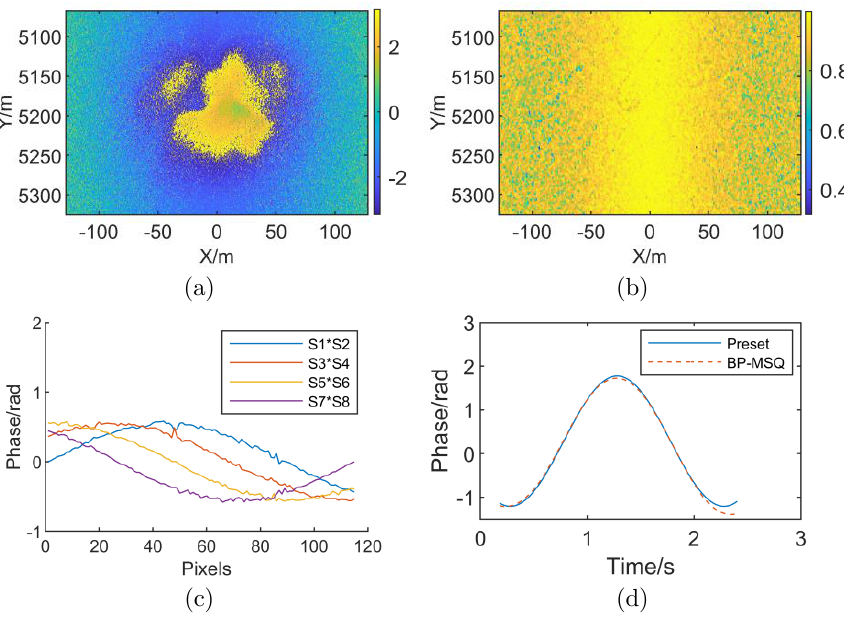
Figure 7. Stripmap SAR simulation results with high-order RME. ( a ) Interferometric phase with high-order RME ( b ) Coherence map with high-order RME ( c ) Subaperture differential interferometric phase ( d ) Comparison of preset value and estimation result of RME